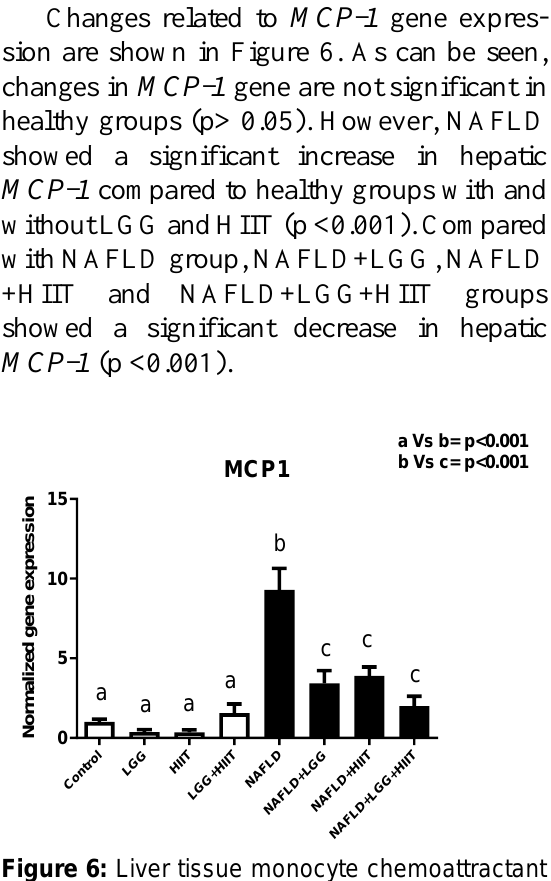
Figure 6: Liver tissue monocyte chemoattractant protein 1 ( MCP1 ) mRNA expression in different groups of study. All values are the mean ± SD (n = 10 per group). Values with different superscripts are significantly different, p < 0.05. LGG: Probiotic